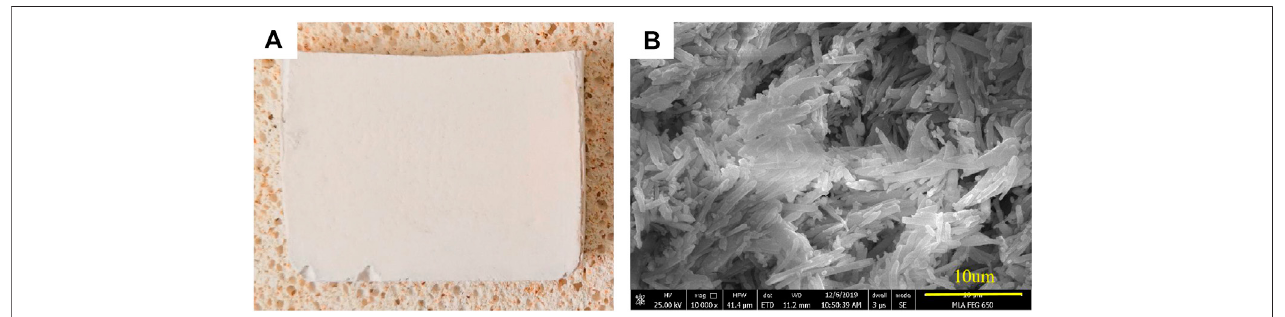
FIGURE 2 | Morphology of Si 3 N 4w after decarbonization: (A) macro photo; (B) SEM photo.